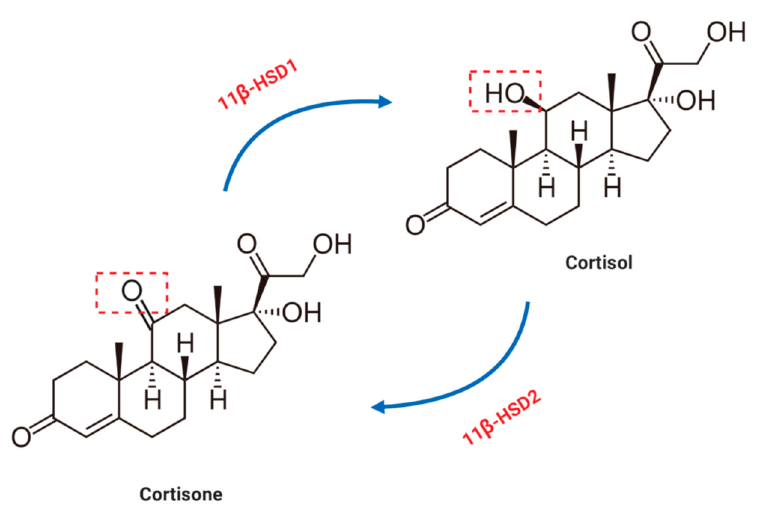
Figure 3. Metabolism of endogenous steroid. 11 β -HSD1 and 11 β -HSD2 regulate the conversion between cortisol and cortisone in vivo.